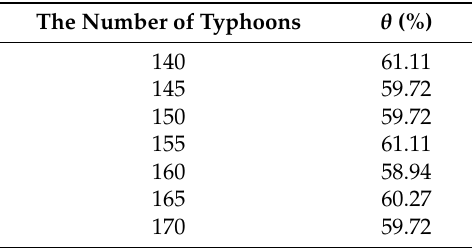
Table 7. Partitioning effect of proposed method by different data sizes.